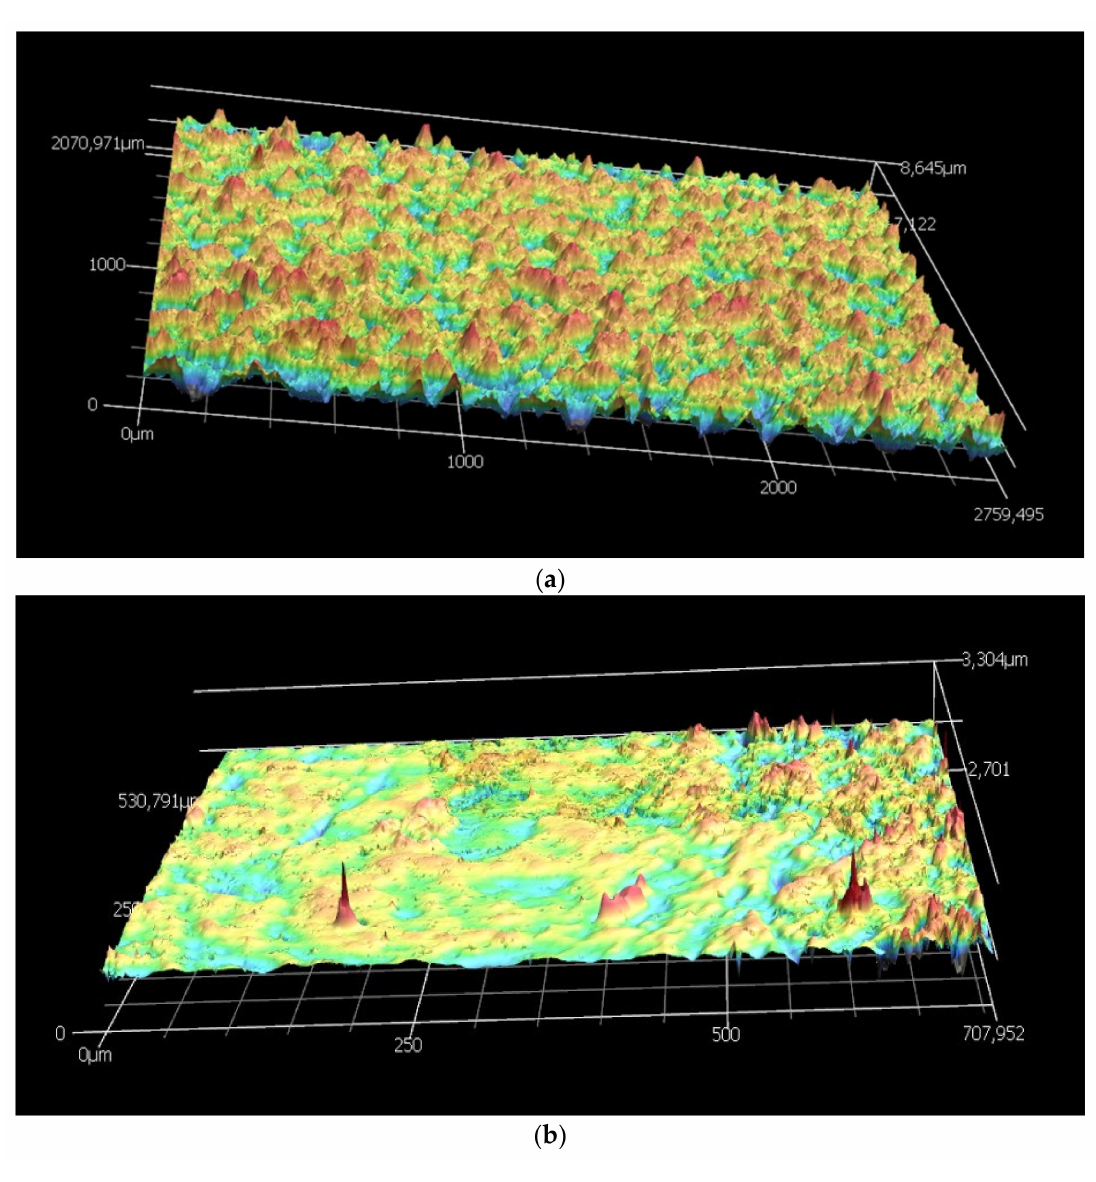
Figure 6. The 3D laser confocal scanning of R80T100 before ( a ) and after ( b ) the post treatment in oxidative atmosphere. Table 3. Post treatment effect on the surface roughness in CMSMs (Carbon Molecular Sieve Mem-